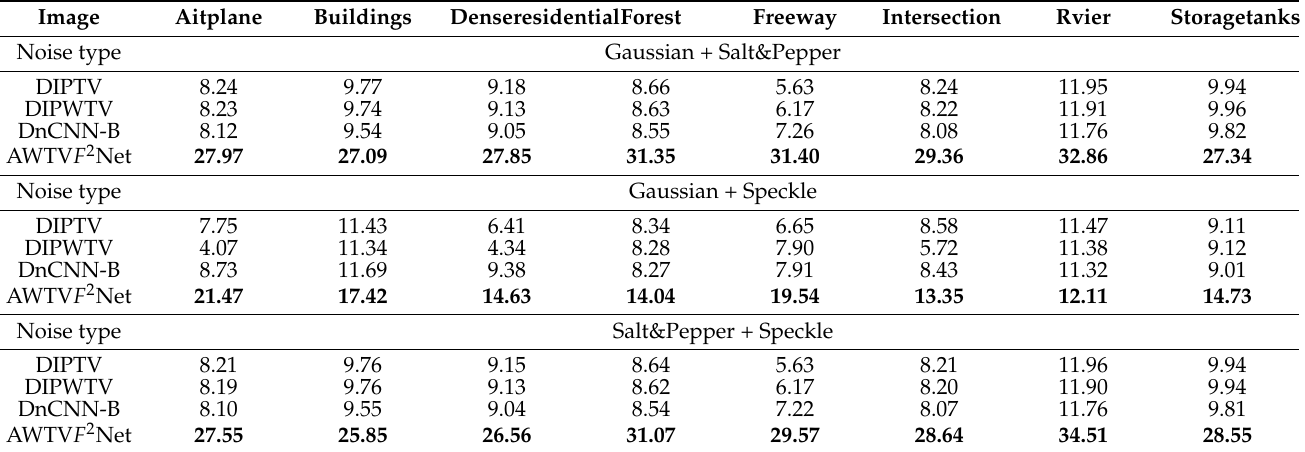
Table 8. Comparison results of different methods on NWPU dataset. The bold values denote the best